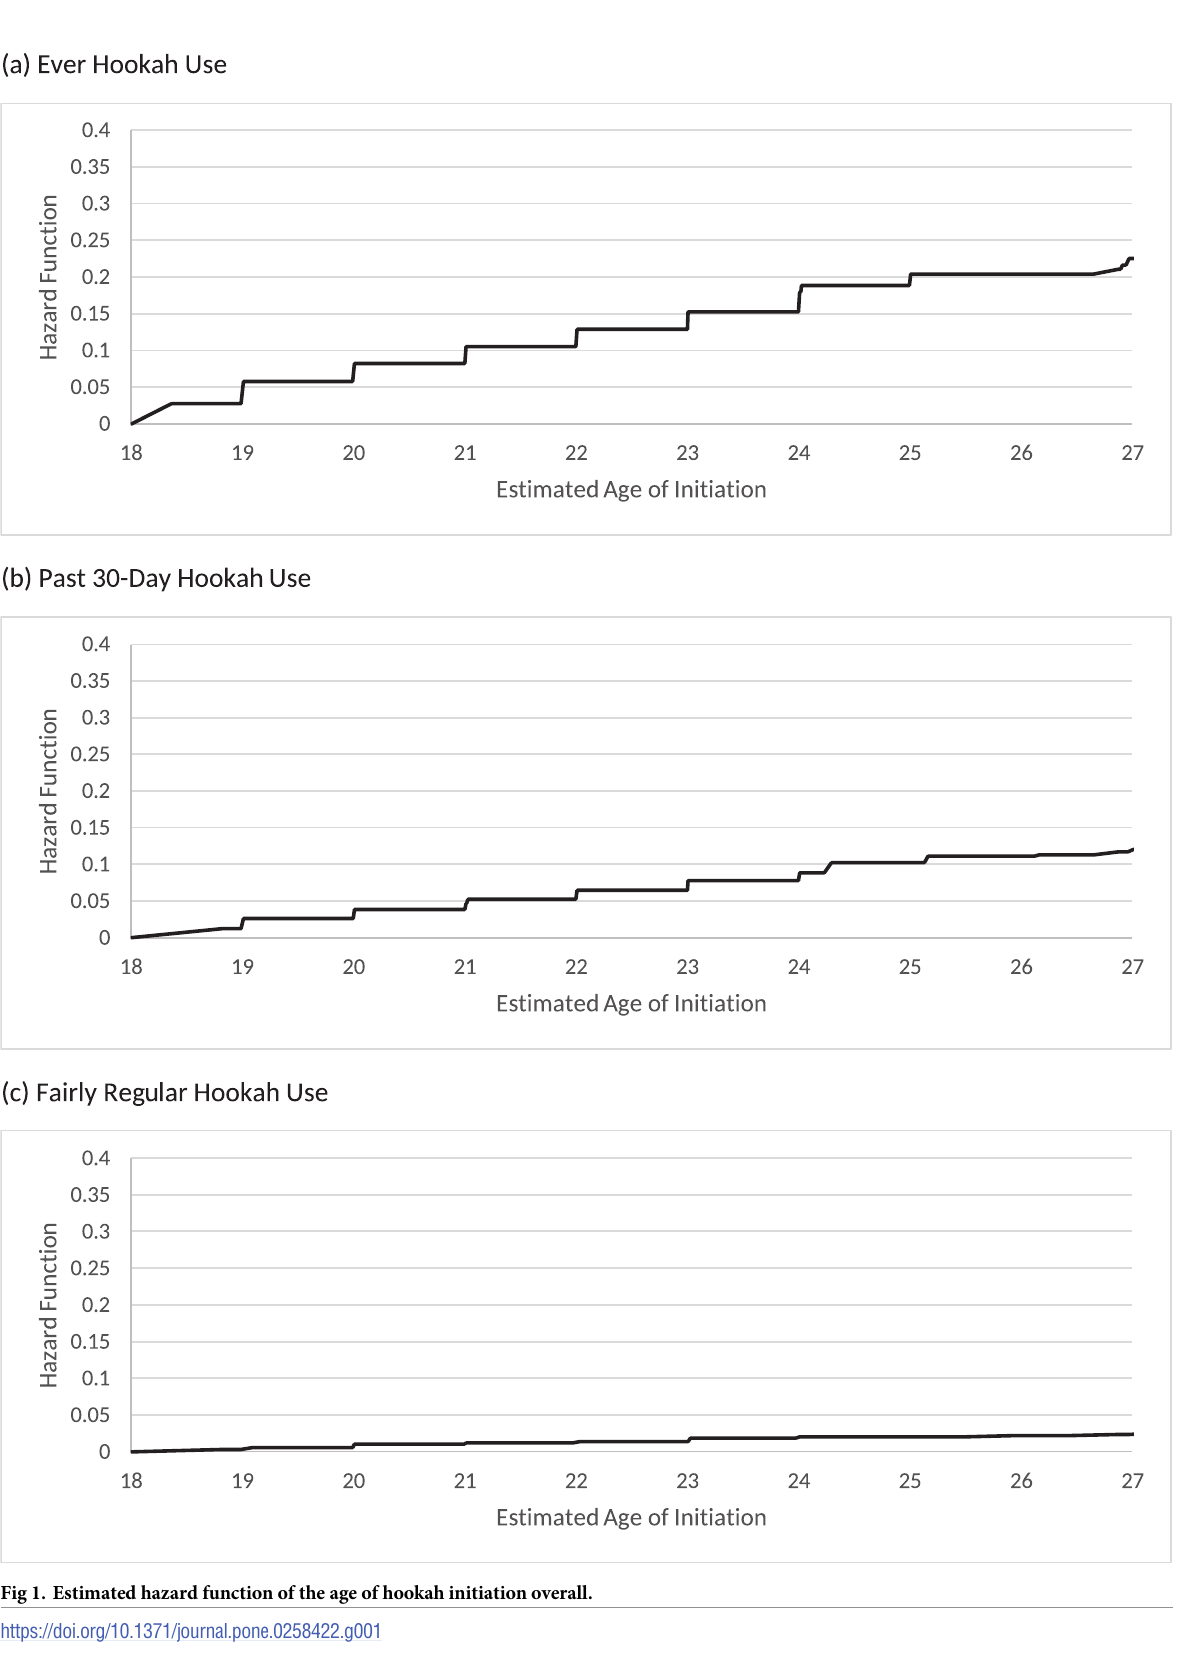
PLOS ONE | https://doi.org/10.1371/journal.pone.0258422 October 12,